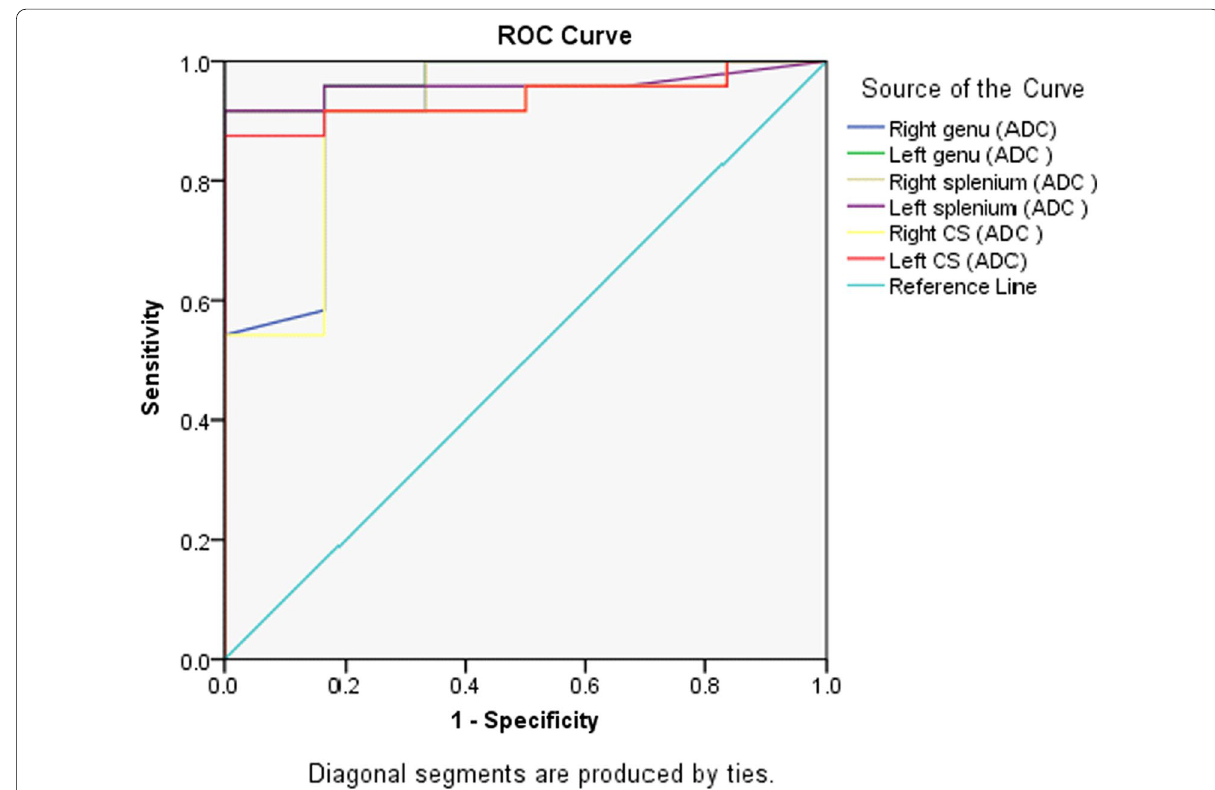
Fig. 3 ROC curve demonstrating specificity and sensitivity of MD in genue, splenium and CS tract on both sides